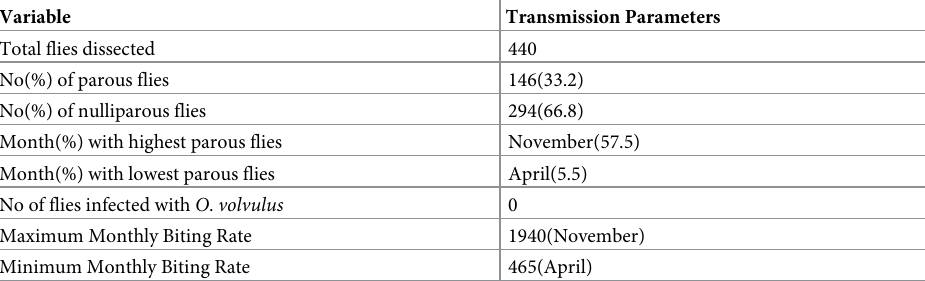
Table 1. Transmission parameters of Simulium damnosum complex in the study